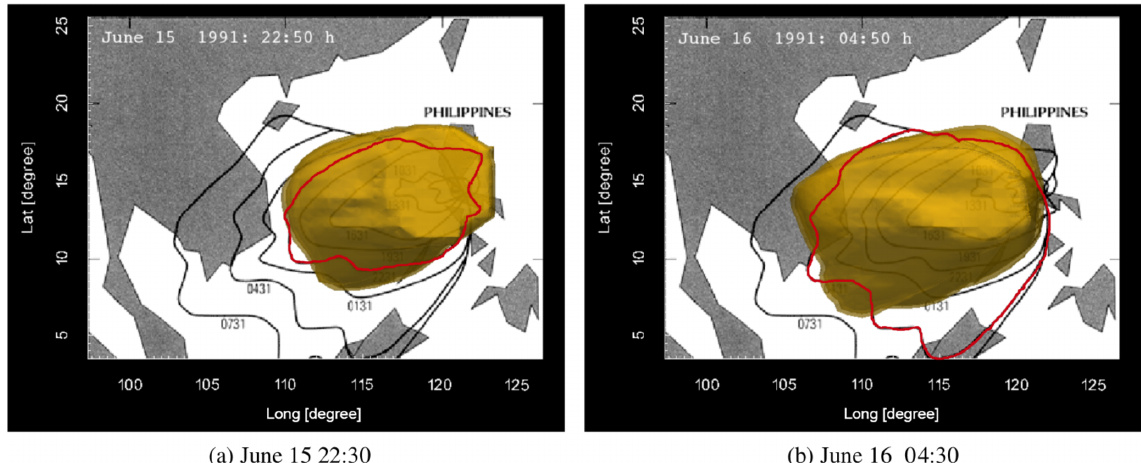
Figure 8. Combined results for particle sizes of 4, 4.5 and 5 φ and the outline of the umbrella cloud identified by Lynch and Stephens (1996).